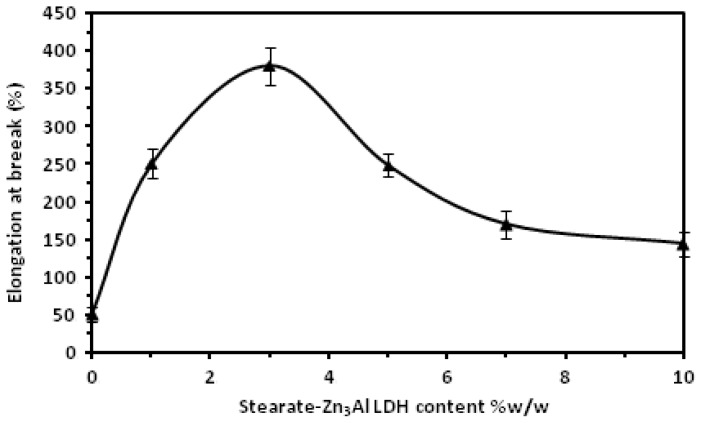
The elongation at break of PLA with different stearate-Zn3Al LDH content.